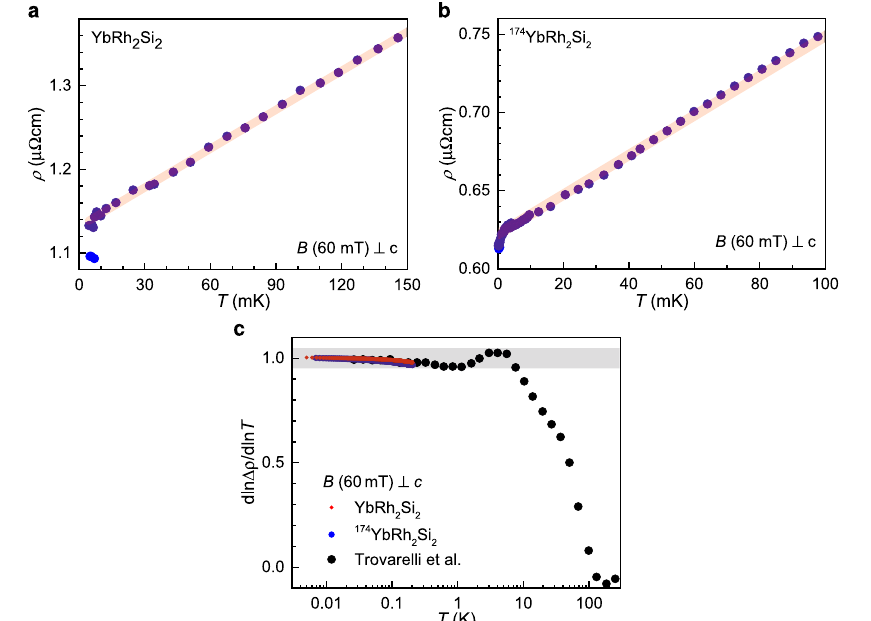
Fig. 2 Strange metal behavior of YbRh 2 Si 2 and 174 YbRh 2 Si 2 . a , b Temperature-dependent electrical resistivity at the quantum critical fi eld of 60 mT applied within the tetragonal a - a plane. Superconductivity develops out of a strange metal ρ ~ T normal state. The parameters of the linear-in- T fi ts are þ A 0 T ϵ , determined as ϵ ¼ dln Δ ρ = dln T , shown together with given in Table 1. c Electrical resistivity exponent ϵ of the non-Fermi liquid form ρ ¼ ρ 0 0 literature data up to high temperatures 15 . This establishes linear-in- T resistivity, evidenced by ϵ = 1 ± 0.05, over 3.5 orders of magnitude in temperature. Note that this presentation visualizes the temperature dependence of the exponent with great sensitivity, and that the error bar of ±0.05 corresponds to a high precision in the exponent ’ s closeness to the value of 1 (for comparison see, e.g., Fig. 12 of ref. 8 ).